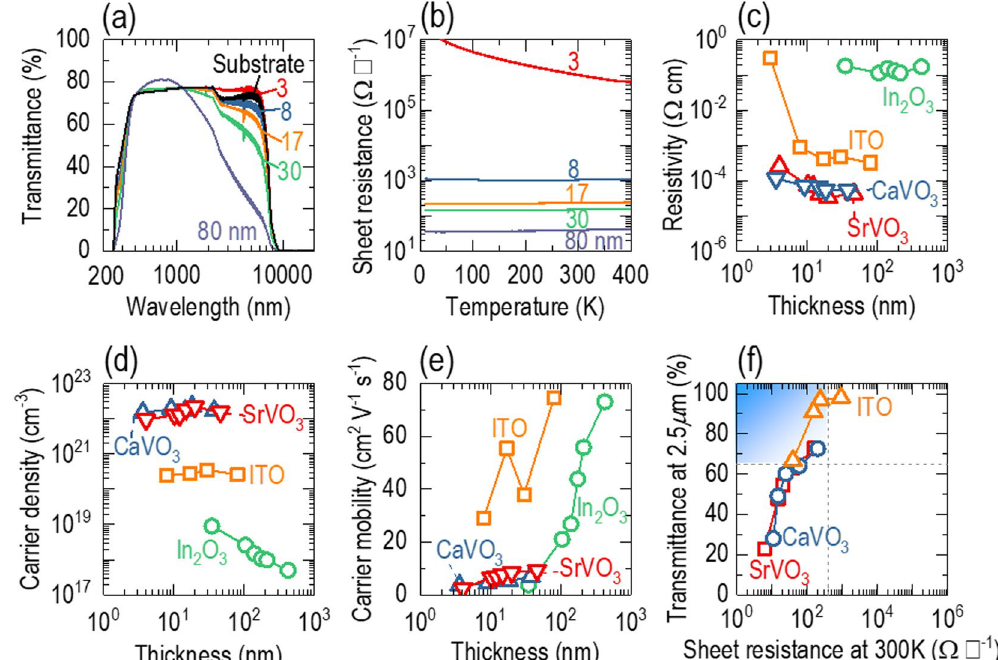
Figure 2. ( a ) Transmittance of ITO epitaxial films as a function of wavelength. With a decrease in the film thickness from 80 to 3 nm, the transmittance increases over a wide range of wavelengths (300–10,000 nm). At the 2.5- μ m wavelength, films thinner than 80 nm show high transmittance ( > 65%). ( b ) Sheet resistance as a function of temperature. With a decrease in the film thickness, the sheet resistance increases. At room temperature, films thicker than 8 nm show low sheet resistance ( < 1,000 Ω □ − 1 ). ( c ) Resistivity as a function of thickness. The resistivity is almost the same over the film thickness range of 8–80 nm but abruptly increases in the 3-nm-thick film. The resistivity of ITO is much lower than that of In 2 O 3 and much higher than those of CaVO 3 and SrVO 3 . ( d ) Carrier density as a function of thickness; ITO epitaxial films have an carrier density of 10 20 ~10 21 cm − 3 . ( e ) Carrier mobility as a function of thickness. The 80-nm-thick film shows a very high mobility of ~75 cm 2 V − 1 s − 1 , which abruptly decreases with decreasing film thickness. Nevertheless, the mobility of ITO is much higher than those of CaVO 3 , SrVO 3 , and In 2 O 3 for all thickness ranges. ( f ) Optimal thickness of ITO epitaxial films for IR-TEs. We plotted the transmittance versus the sheet resistance. The region highlighted in blue indicates the films that satisfy both the transmittance and sheet resistance requirements ( > 65% and < 400 Ω □ − 1 , respectively). ITO epitaxial films are in this region for 17 − 80 nm thicknesses; CaVO are in this region for films thinner than 10 nm. Data for CaVO 3 , SrVO 3 , and In 2 O 3 are taken from refs. 18,19 ,